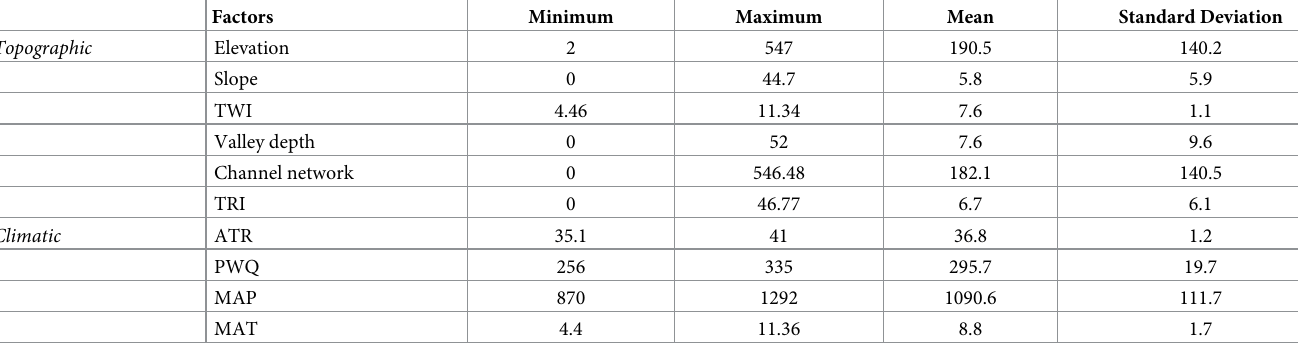
Table 1. Descriptive statistics for topographic and climatic factors across study area.